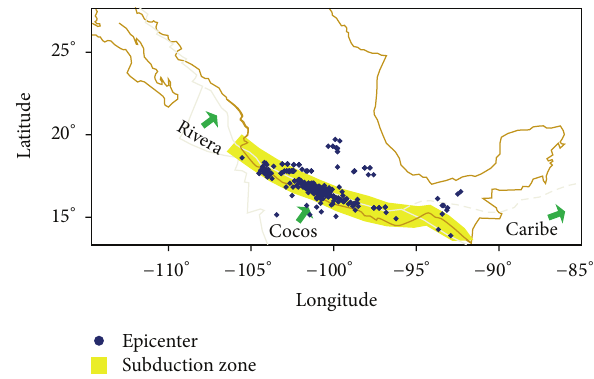
Figure 10: Motion array and events included in the data base.